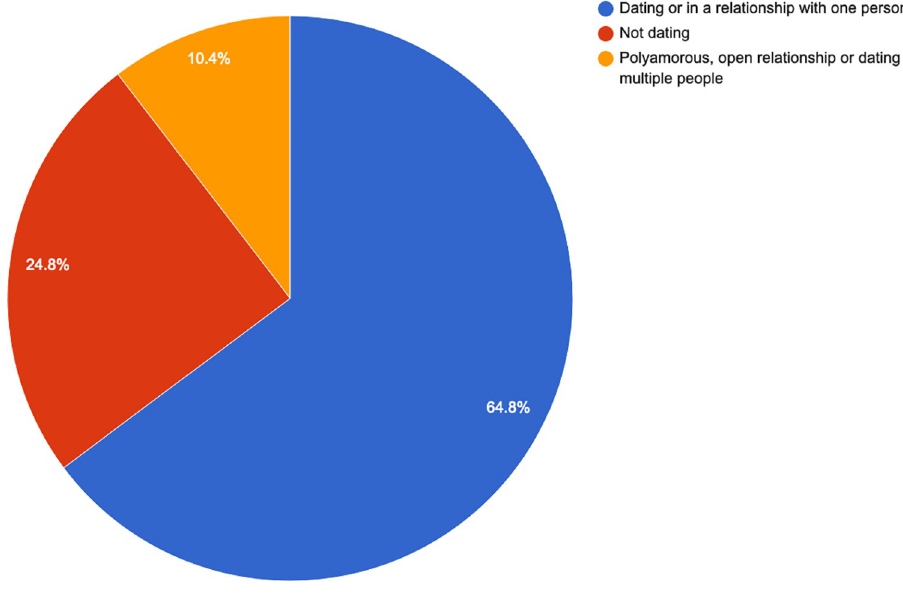
Fig 10. Relationship